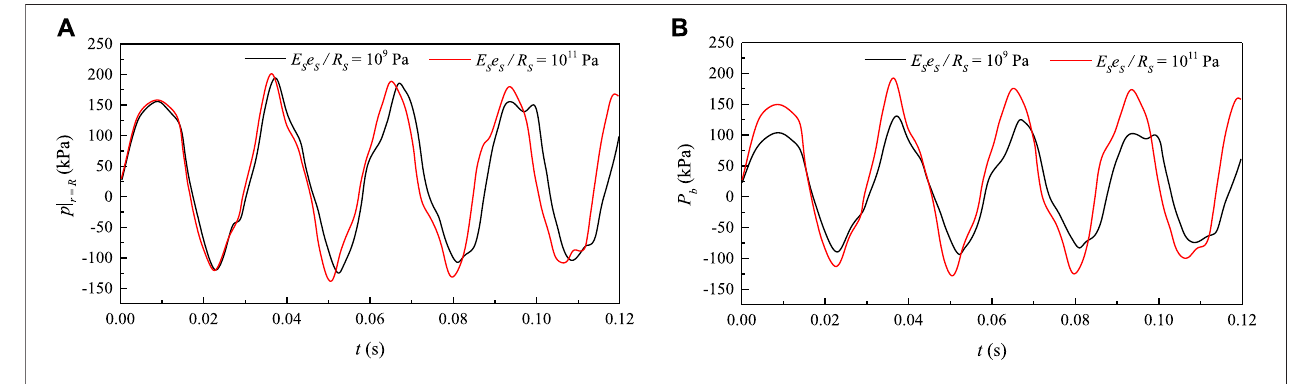
FIGURE 11 | Pressure fl uctuates with E s e s /R s (A) On the inner interface. (B) On the outer interface.